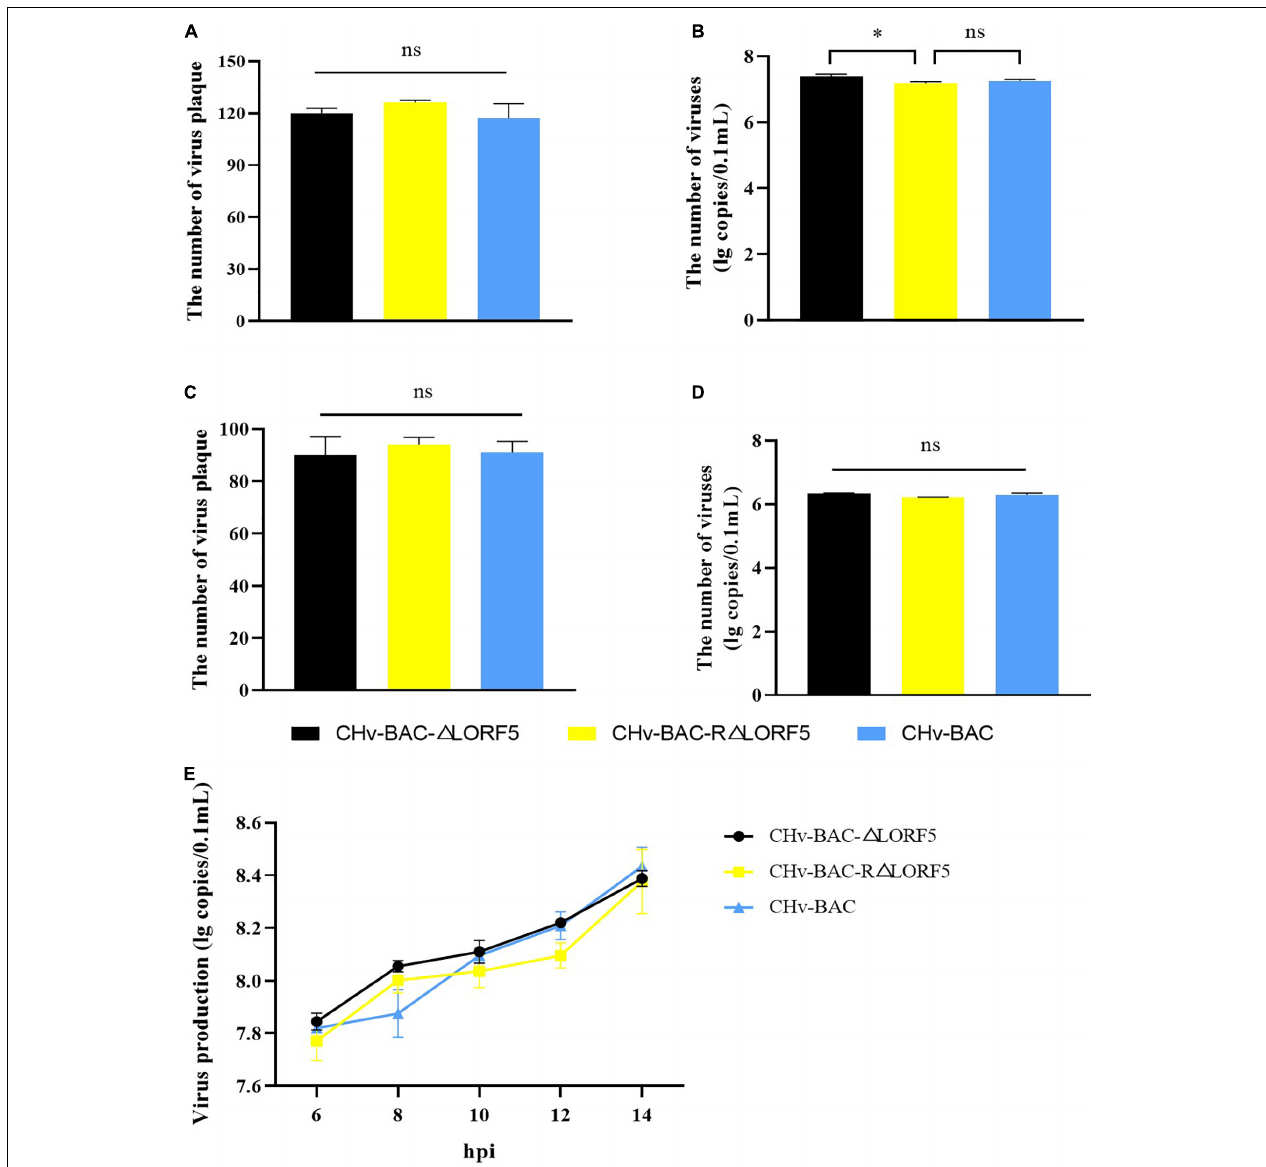
FIGURE 4 | The influence of LORF5 on virus adsorption, invasion, and replication. (cid:49) LORF5, R (cid:49) LORF5, and CHv-BAC (0.001 MOI) were inoculated into DEF cells. On the one hand, the number of virus plaques was calculated to study the ability to adsorb on the cell surface (A) or invade cells (C) after 24 hpi; on the other hand, cell samples were collected 0–2 h after incubating viruses, and the copies were separately detected simultaneously (B,D) . (E) Cell samples infected with (cid:49) LORF5, R (cid:49) LORF5, and CHv-BAC (1 MOI) were collected, RNAs were extracted and reverse-transcribed into cDNA as a template to detect the virus copy number by q-PCR ( t -test, ∗ P <